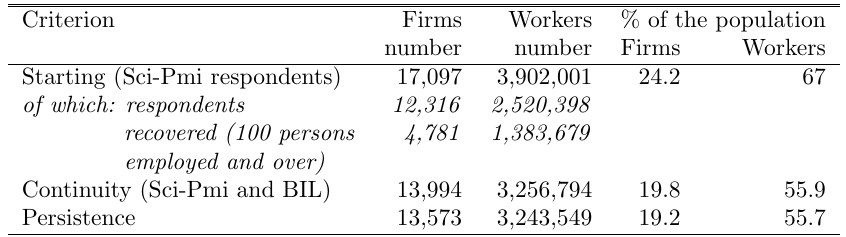
Panel 1998-2007 firms number and